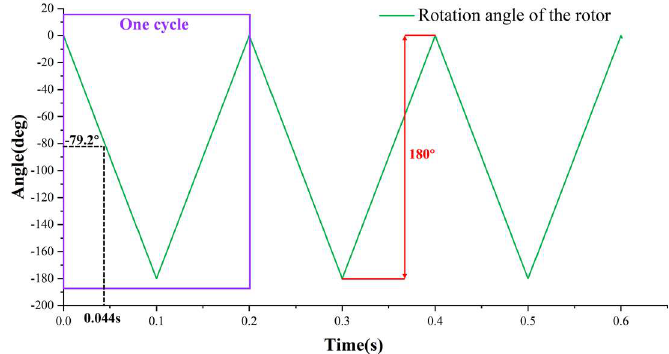
Figure 7. The curve of the rotation angle of the rotor. Table 2. Comparison between the simulation and theoretical